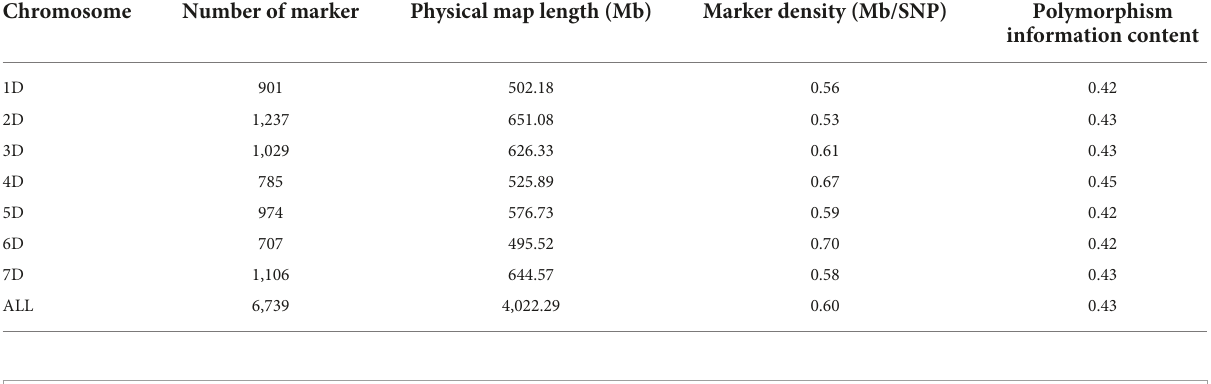
TABLE 1 Distributions of single nucleotide polymorphisms, density, and polymorphism information content of 286 Aegilops tauschii accessions.